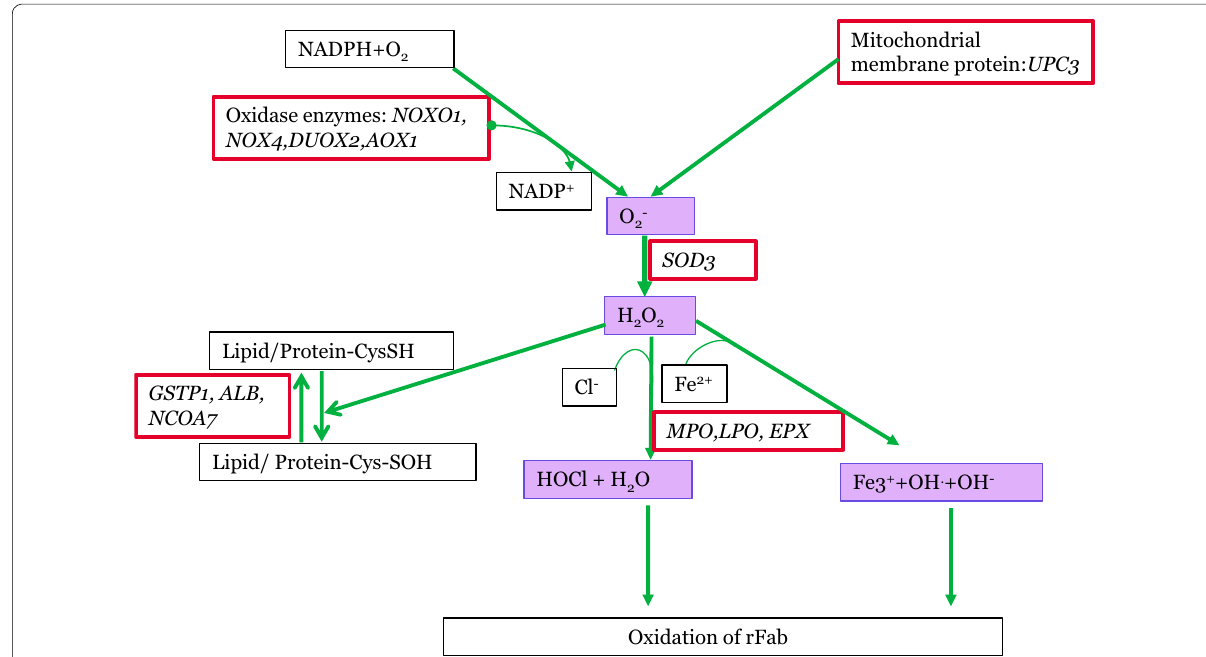
Fig. 9 Schematic diagram illustrating a proposed pathway for rFab oxidation for cells under oxidative stress. The 12 genes identified in the red boxes were found to be highly transcribed in this study; AOX1, Aldehyde Oxidase 1; NOXO1, NADPH Oxidase Organizer 1; EPX, Eosinophil Peroxidase; NOX4, NADPH Oxidase 4; DUOX2, Dual Oxidase 2; UPC3, Uncoupling Protein 3; SOD3, Superoxide Dismutase 3; LOP, Lactoperoxidase; MPO, Myeloperoxidase; GSTP1, Glutathione S -Transferase; ALB, Serum Albumin Like; and NCOA7, Nuclear Receptor Coactivator 7. NOXO1, NOX4, DUOX2, AOX1, SOD3, MPO, LPO and EPX genes are all involved with the formation of ROSs (highlighted in the purple boxes), while UPC3 is responsible for pumping ROSs out of the mitochondria. GSTP1, ALB and NCOA7 are protective; their main function is to protect thiol containing proteins and lipids from oxidation by acting as a reducing agent and are not involved in reducing the level of H 2 O 2 found within the